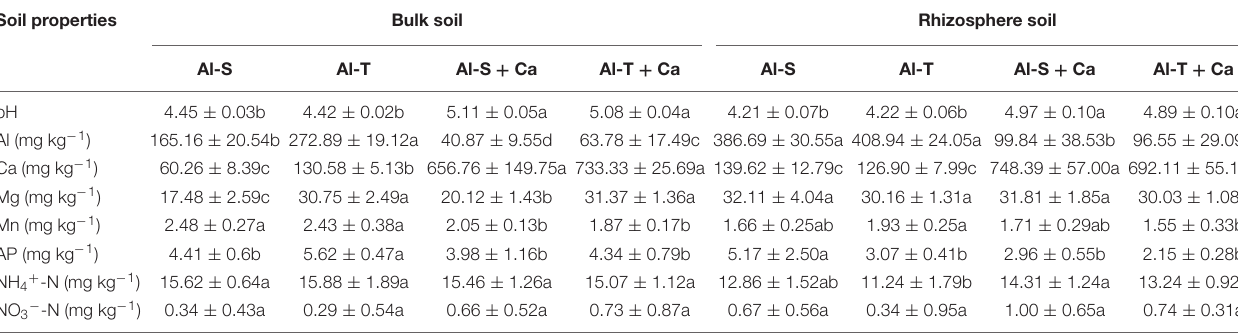
TABLE 2 | Soil chemical properties. Soil properties Bulk soil Rhizosphere soil